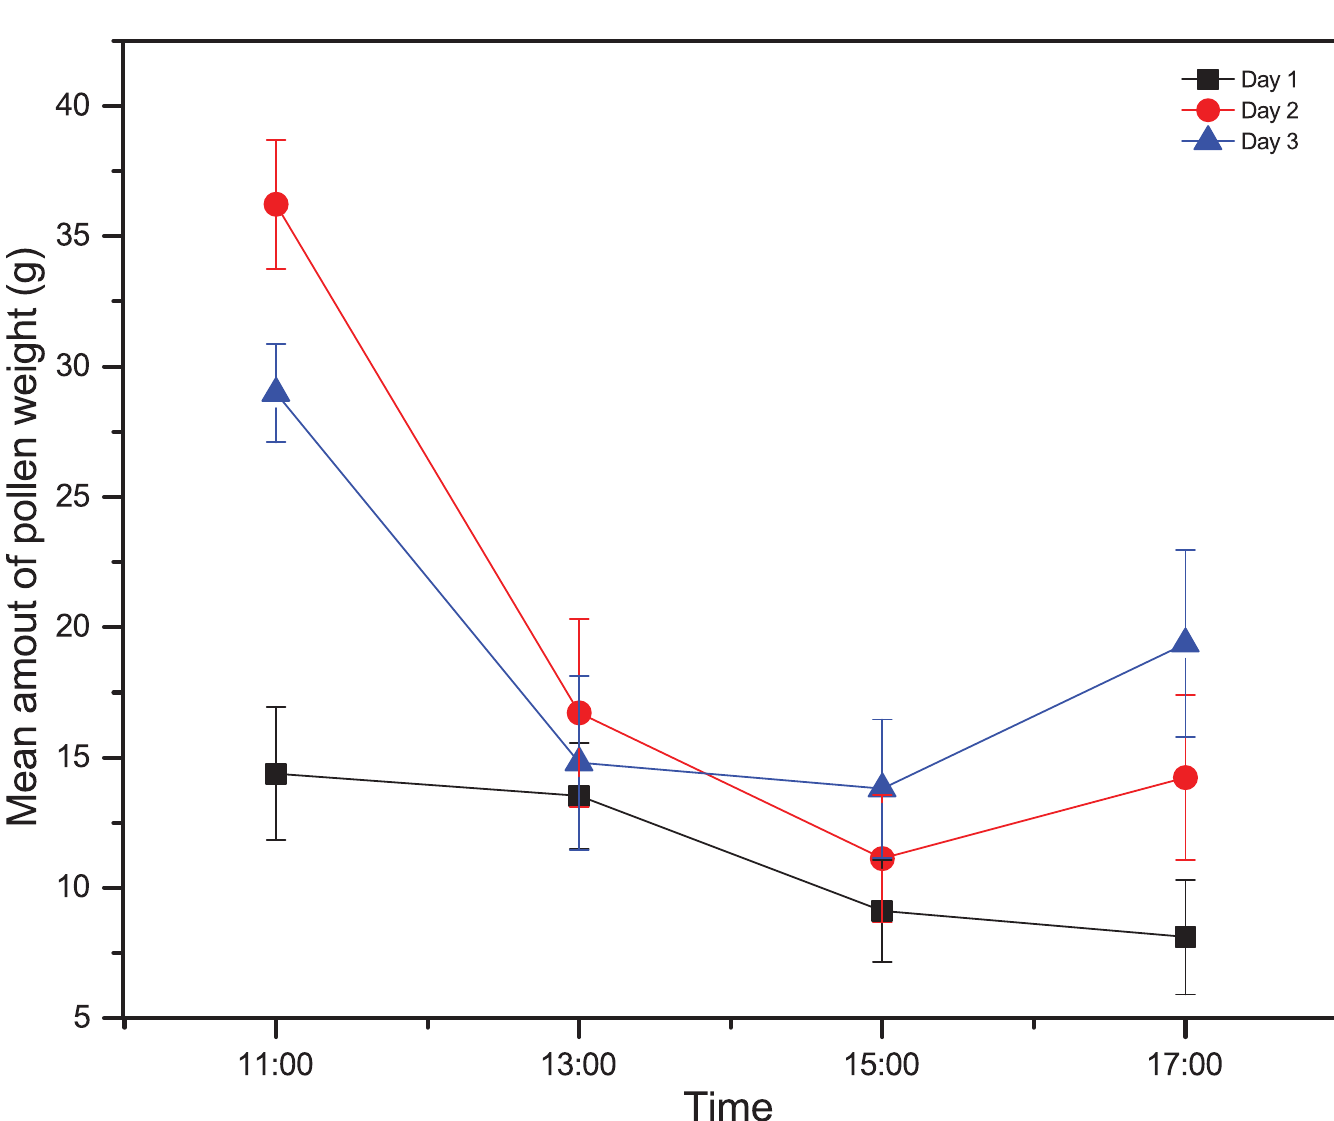
Fig 4. Mean amount of pollen weight measured at different time of days. Figures are pollen weight across time of different days (Day 1, Day 2 and Day 3). Plotted data are means and standard errors significant differences at P = 0.05 level.